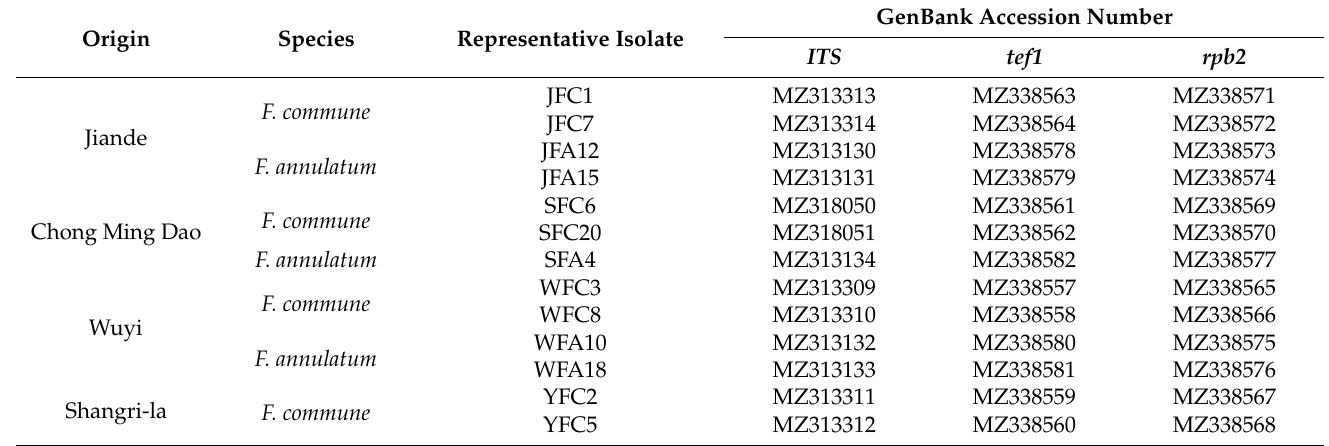
Table 2. Saffron isolates of Fusarium spp. from four plantation regions of China used in this study and their GenBank accession